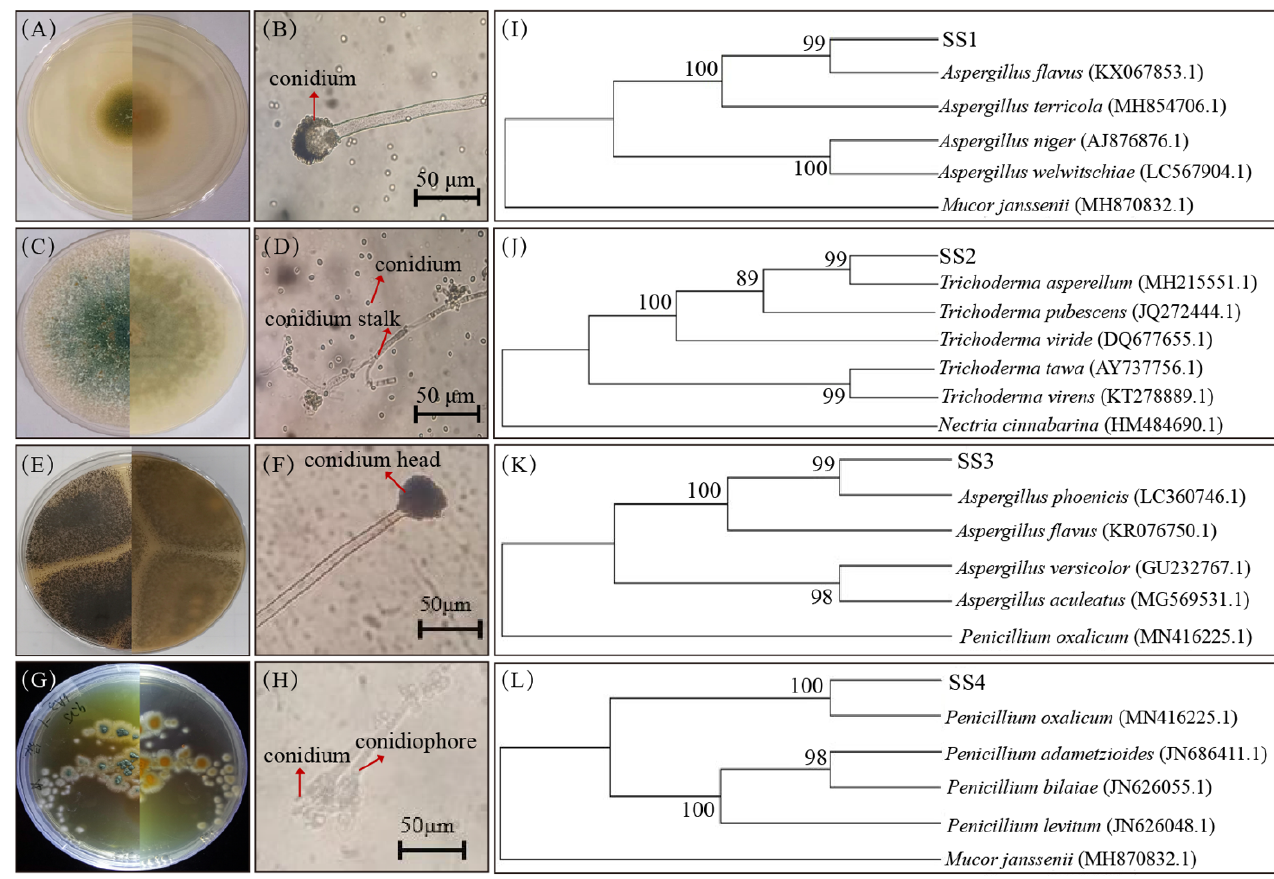
Figure 1. Morphological and molecular identification of the SS1 strain, SS2 strain, SS3 strain, and SS4 strain. The morphology of the SS1 strain ( A , B ); The morphology of the SS2 strain ( C , D ); The morphology of the SS3 strain ( E , F ); The morphology of the SS4 strain ( G , H ); Phylogenetic trees of four fungal strains: SS1strain ( I ), SS2 strain ( J ), SS3 strain ( K ), and SS4 strain ( L ) with other related strains based on rDNA-ITS sequences by the neighbor-joining method. The scale bar was 50 µ m ( B , D , F , H ). The rDNA-ITS sequences of four fungal strains were cloned for further